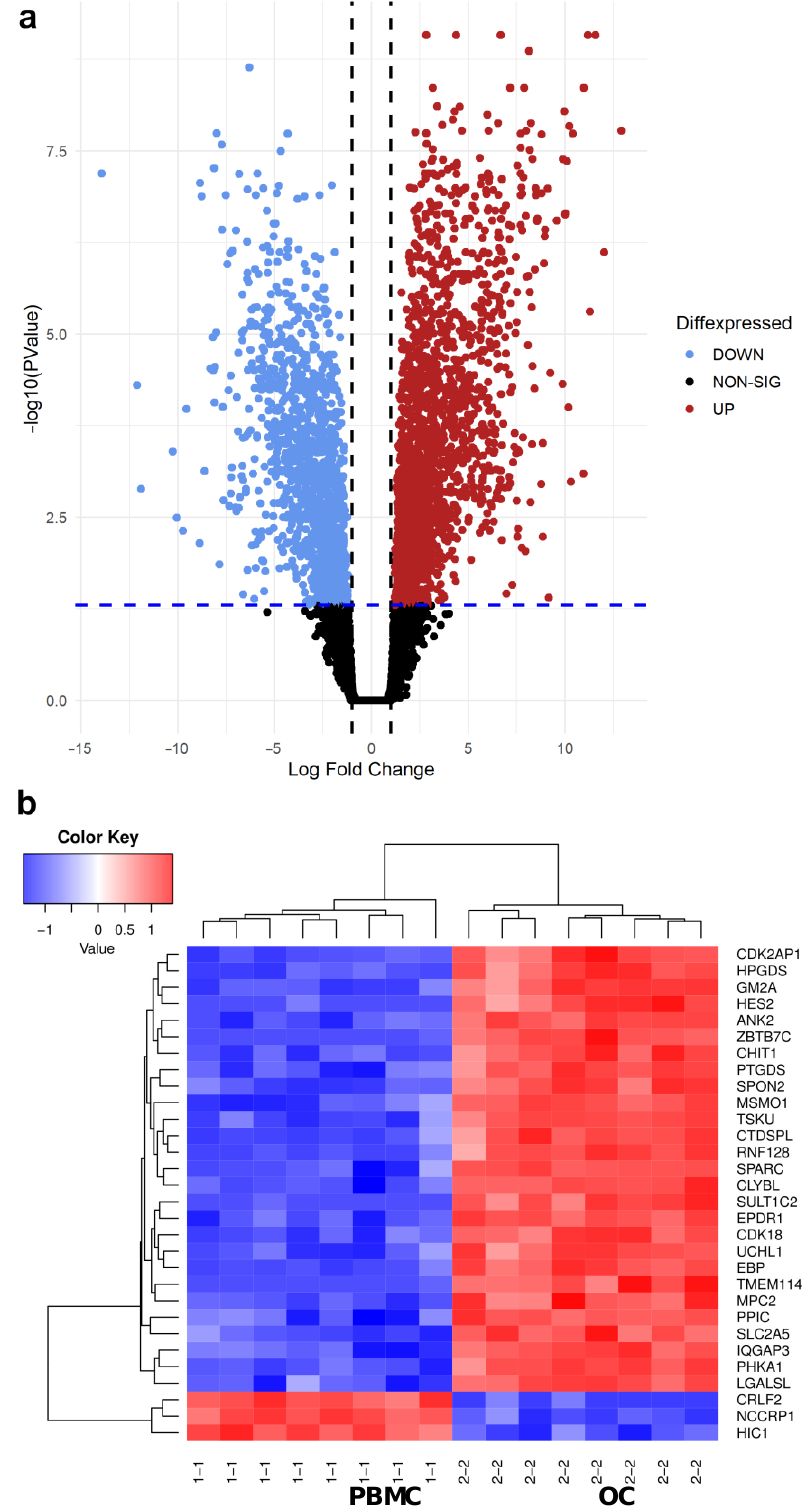
Figure 1. ( a ) Volcano plot illustrating the DEGs between the OC and PBMC groups. Genes signifi- cantly up- and downregulated in the OC group relative to the PBMC group are indicated using red and blue dots, respectively. ( b ) Heat map based on the hierarchical clustering for the top 30 differ- entially expressed genes identified between the PBMC and OC groups.